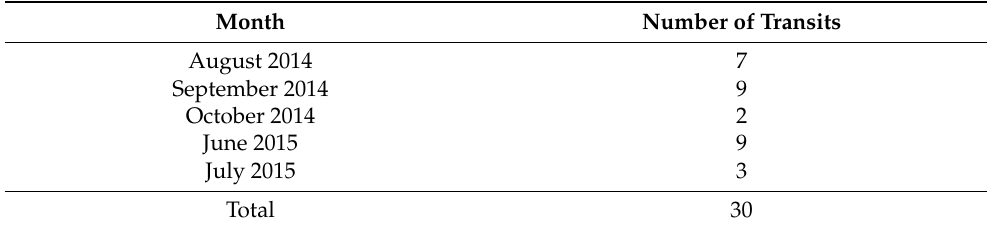
Table A7. Lastovo–Mljet passage—number of cruise ships’ transits in selected high-risk navigational and environmental locations